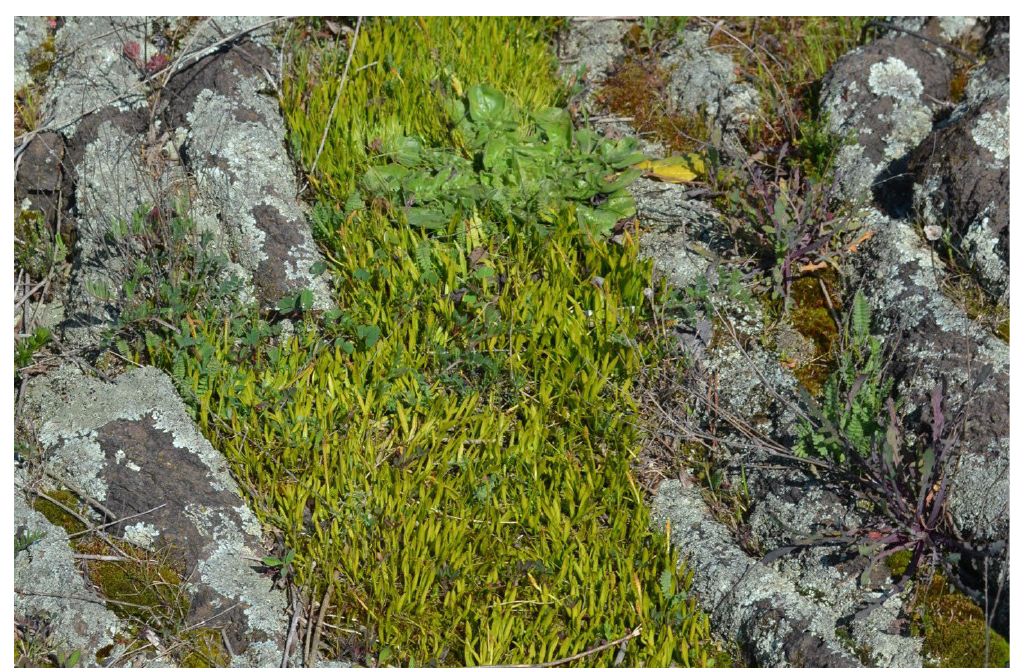
Figure 5. Euphorbio exiguae-Ophioglossetum lusitanici ass. nova hoc loco. Date: 3 May 2021, Santeramo in Colle, in loc. Alessandrelli (Bari). Photo by Enrico Vito Perrino.